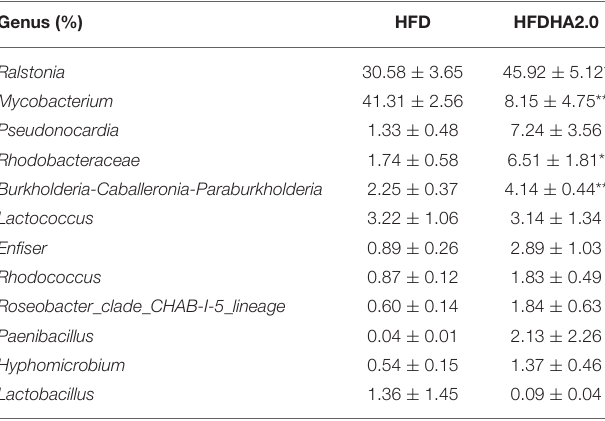
TABLE 6 | The predominant gut bacterial genus in zebrafish fed with HFD or HFDHA2.0 for 4 weeks based on V3–V4 sequences. Genus (%) HFD